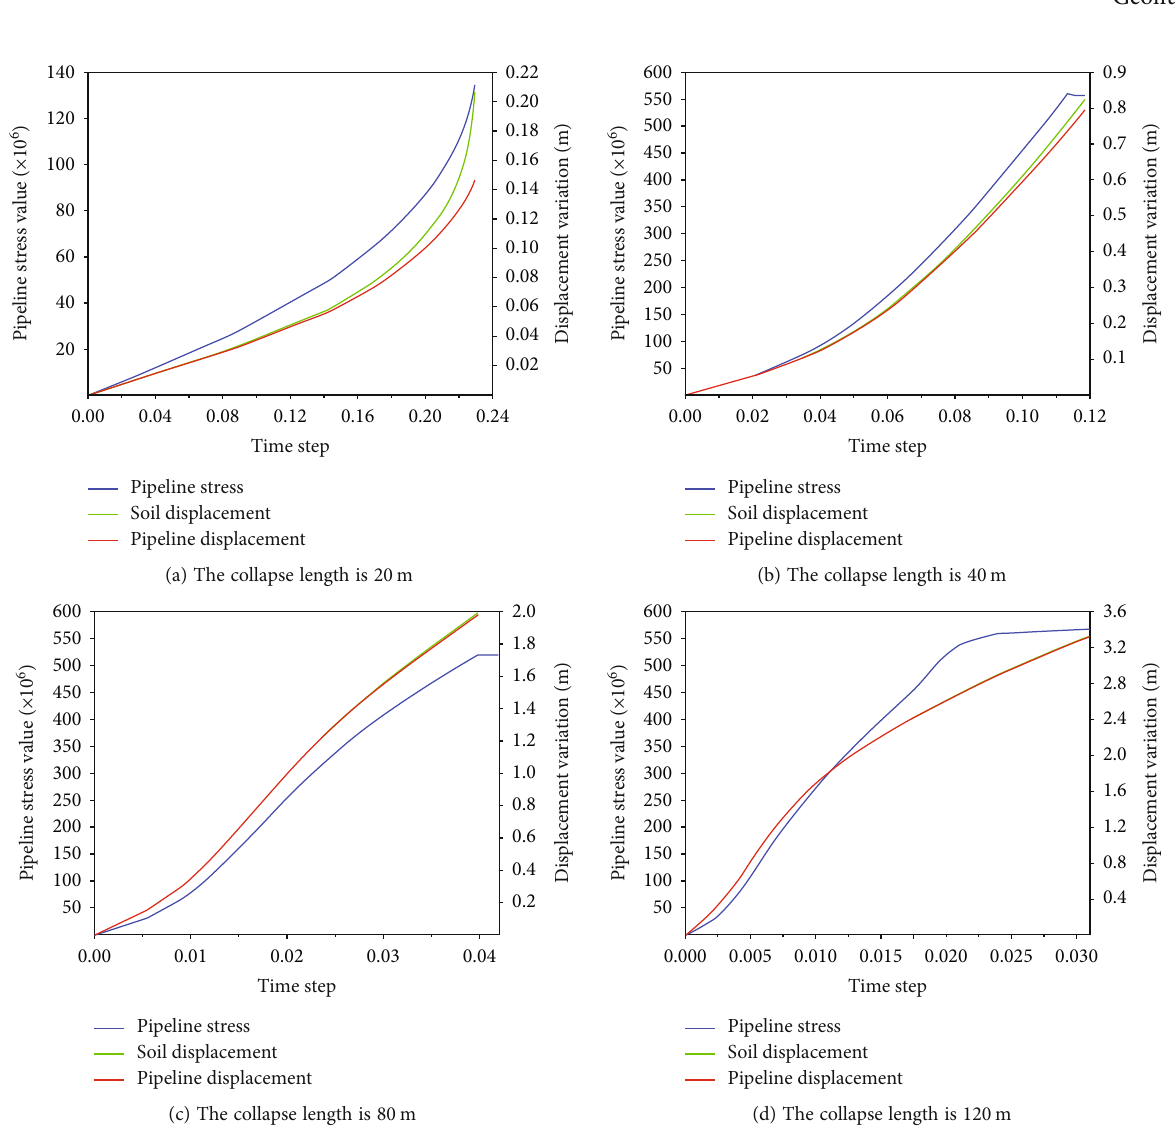
Lengths. Figure 4 is the nephograms of soil displacement under four di ff erent collapse lengths. When the length of the subsidence area is 20 m, the displacement of the soil on both sides of the pipeline in the subsidence area is large, and the displacement of the soil in the middle is small. This indicates that the pipeline exerts upward support on the soil.